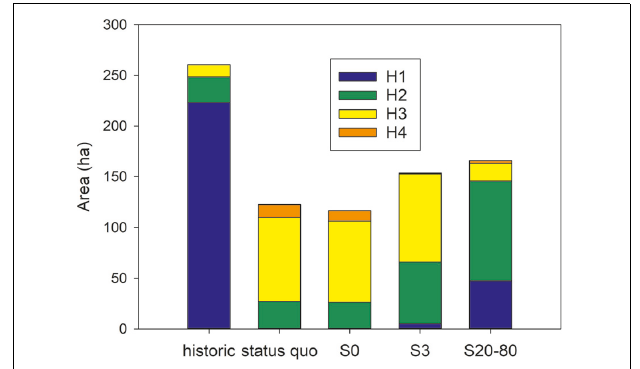
Frontiers in Environmental Science |